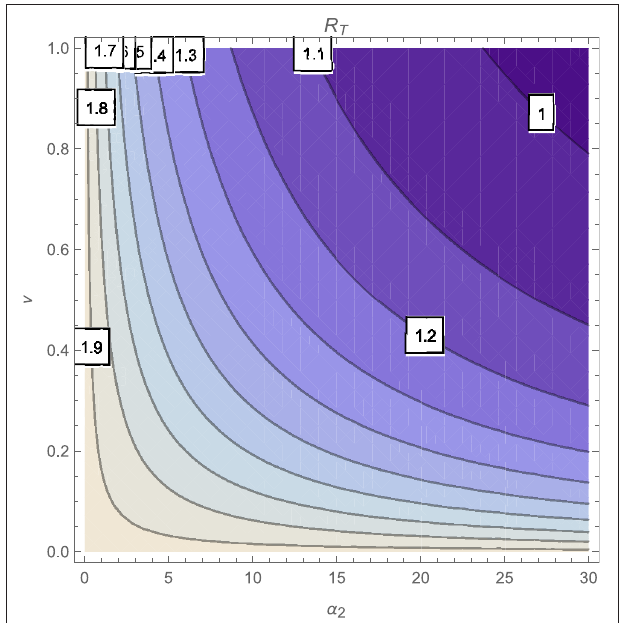
FIGURE 3 | Contour plot of R T as a function of ν and α 2 .